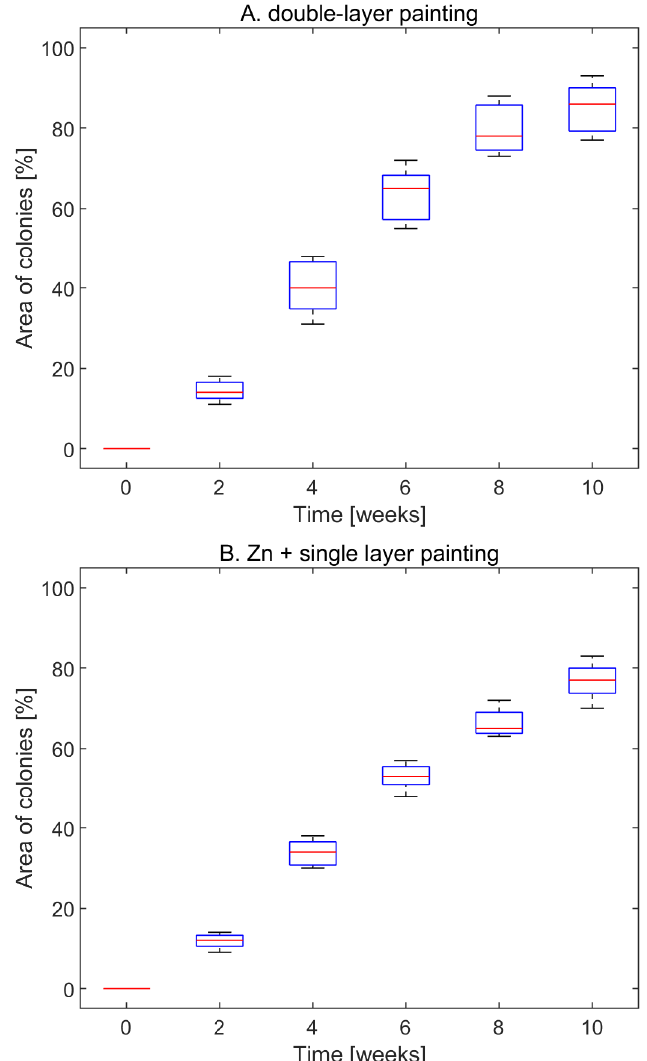
Figure 4. Percentage of areas with changes in the biomass layer. ( a ) Double-layer coating, ( b ) zinc- paint coating.